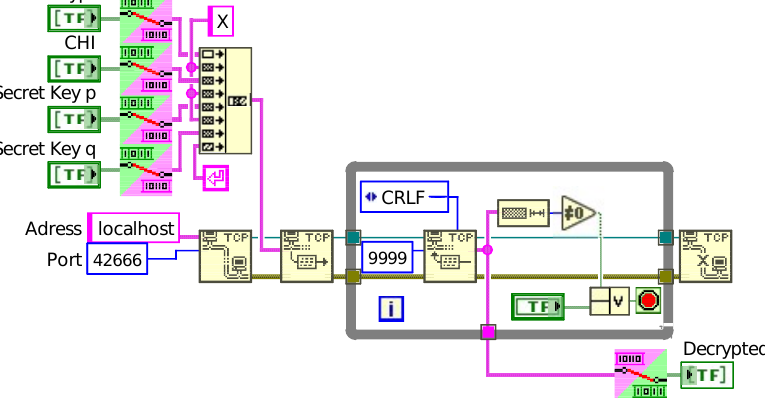
Figure 6. LabVIEW part of the time-optimized decryption process. The crypt, CHI and secret keys are prepared and then transferred via the established TCP/IP connection to the Java application on the localhost. Afterwards, the program waits for a response from the Java application. The plain message is shown at the frontend after reception and the TCP/IP connection is